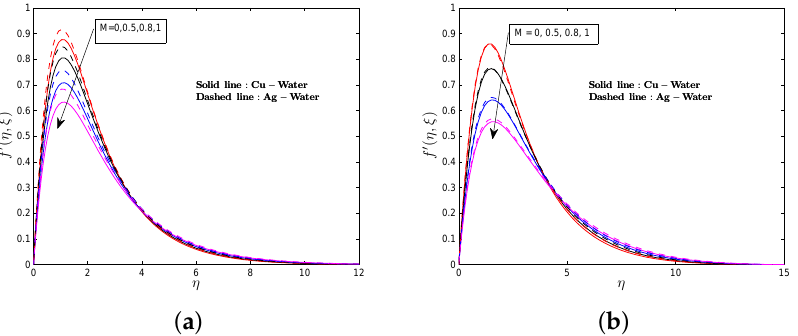
Figure 4. Velocity profiles for various values M . ( a ) vertical plate; ( b ) horizontal plate.